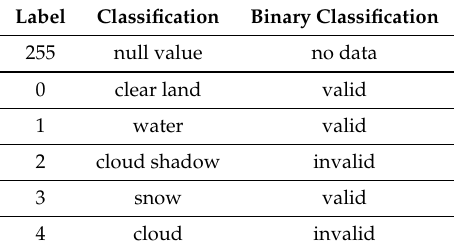
Table 5. Conversion of FMask mask classes to valid/invalid.